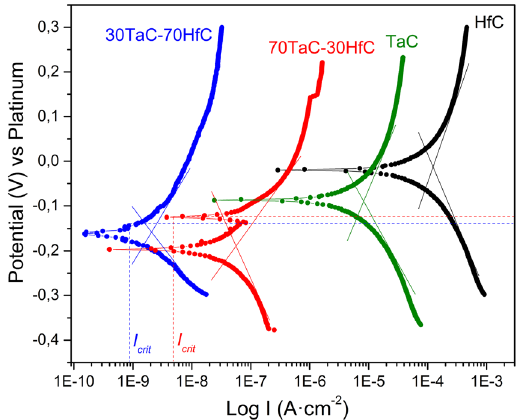
Figure 7. Potentiodynamic polarization curves of the Ta-Hf-C samples at 700 °C. Tafel slopes are drawn on the potentiodynamic curves. The critical current and potentials for 30TaC-70HfC and 70TaC-30HfC samples are also